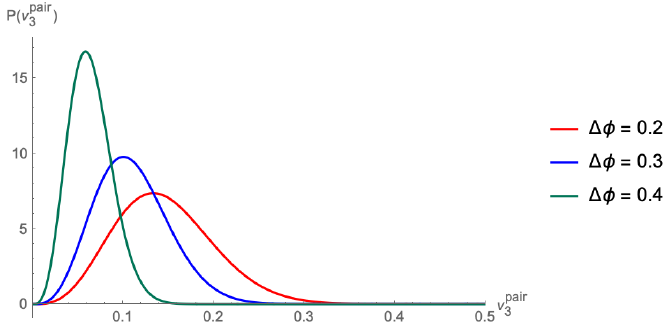
) over the pair flow coefficient v pair 3, c